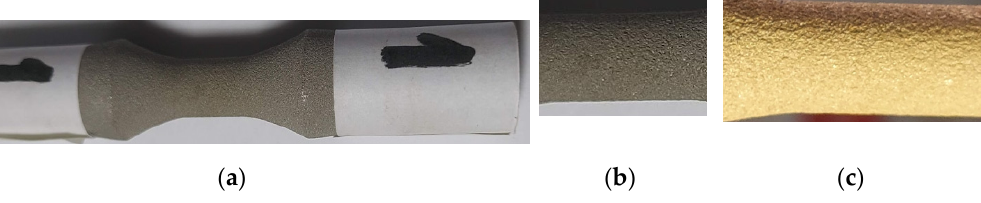
Figure 9. Macroscopic appearance of the outer surface after fatigue stress—Sample 1 σ max = 420 MPa, N = 5,519,600 cycles. ( a ) the unbroken sample after more than 5 million cycles (8×). Macroscopic image of the surface for ( b ) 32× and ( c ) 45× magnification. Sample 8 had a similar appearance.